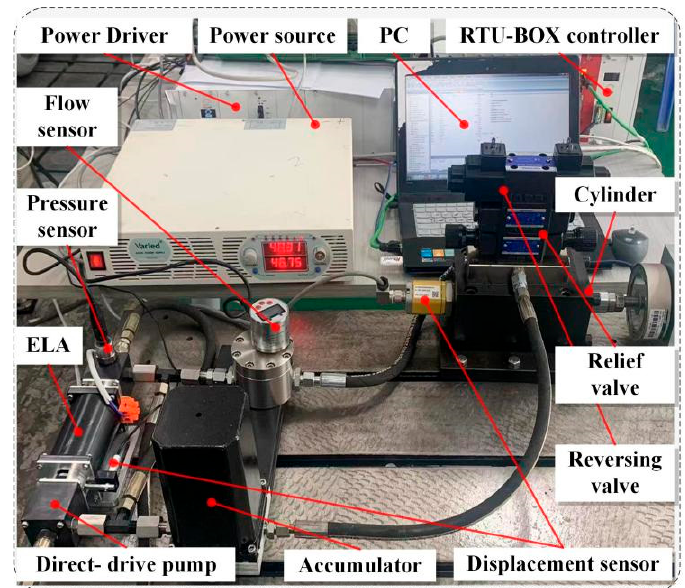
Figure 5. Experimental platform of DEHAS.